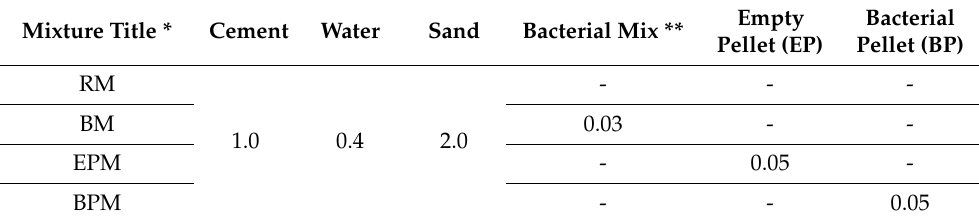
Table 2. Mixture proportions for the mortar by cement weight